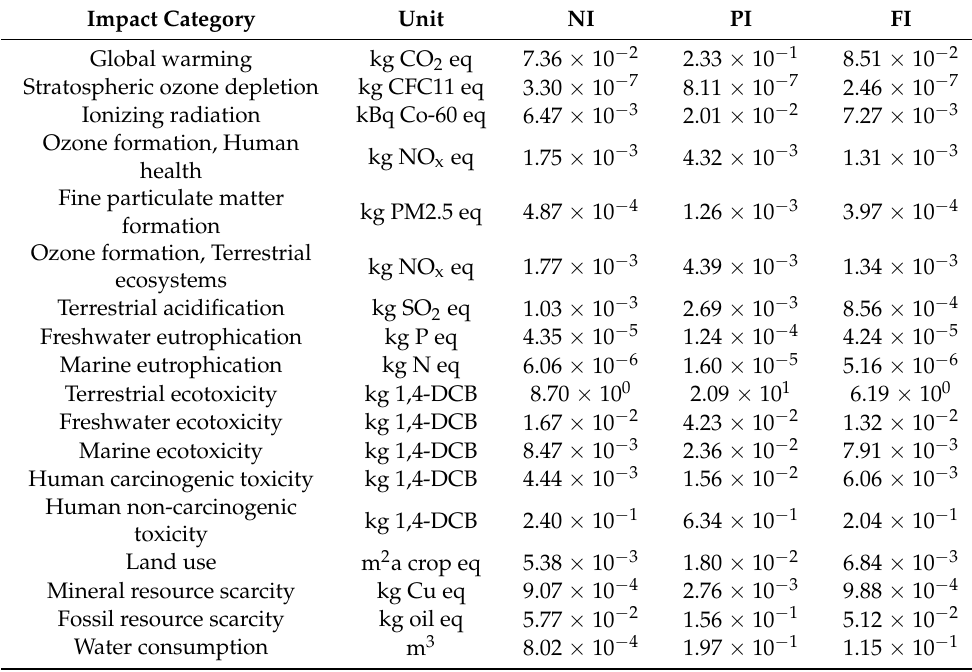
Table 8. Life Cycle Impact Assessment through the ReCiPe Midpoint method (per kg of olive